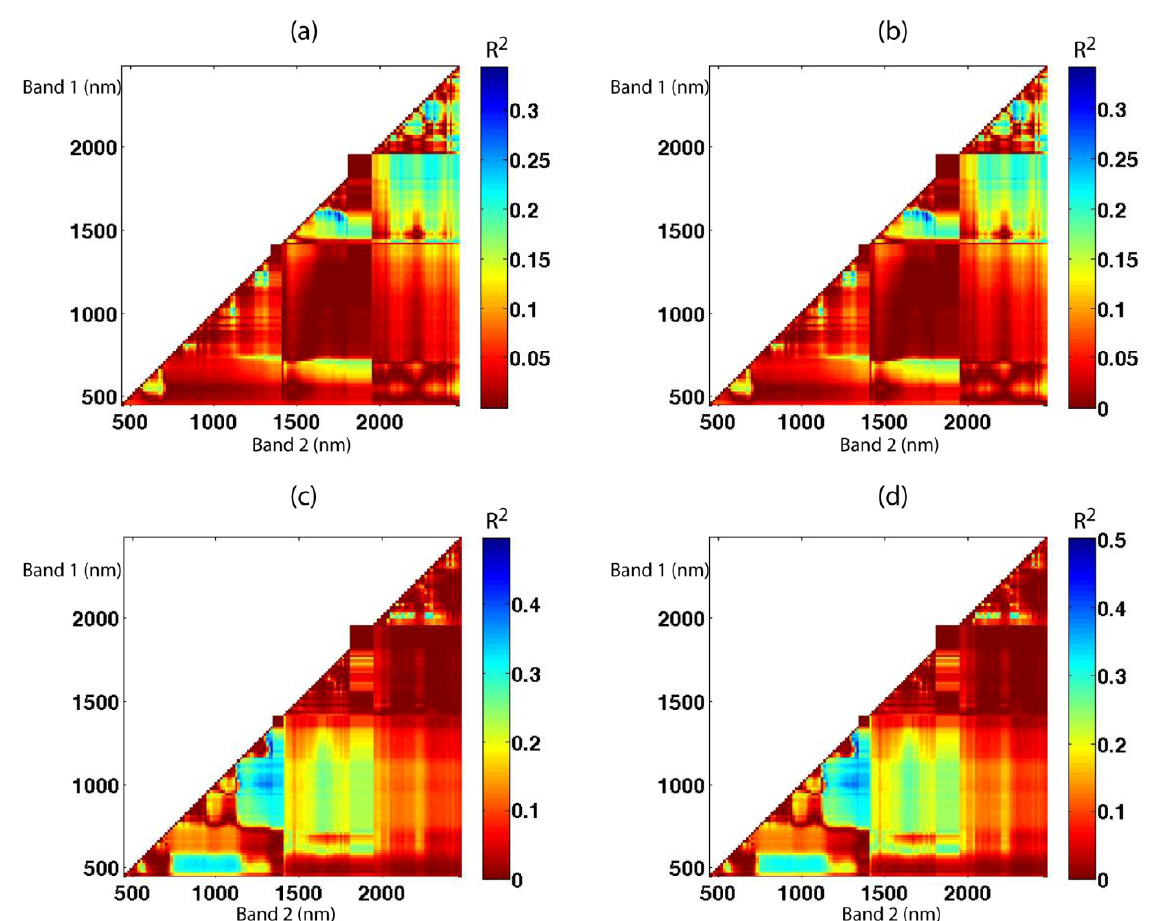
Figure 3 . The correlation matrices using the vegetation index approach to estimate LAI: using ( a ) VI1, and ( b ) VI2 for the Monticello, UT site; and using ( c ) VI1 and ( d ) VI2 for the Monument Valley, AZ